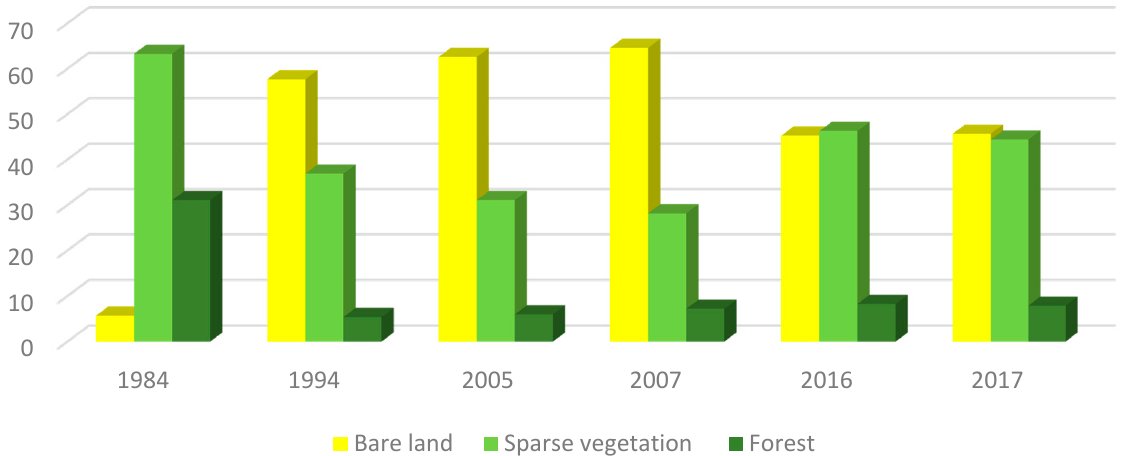
Figure 8. Evolution of different land cover between 1984 and 2017.